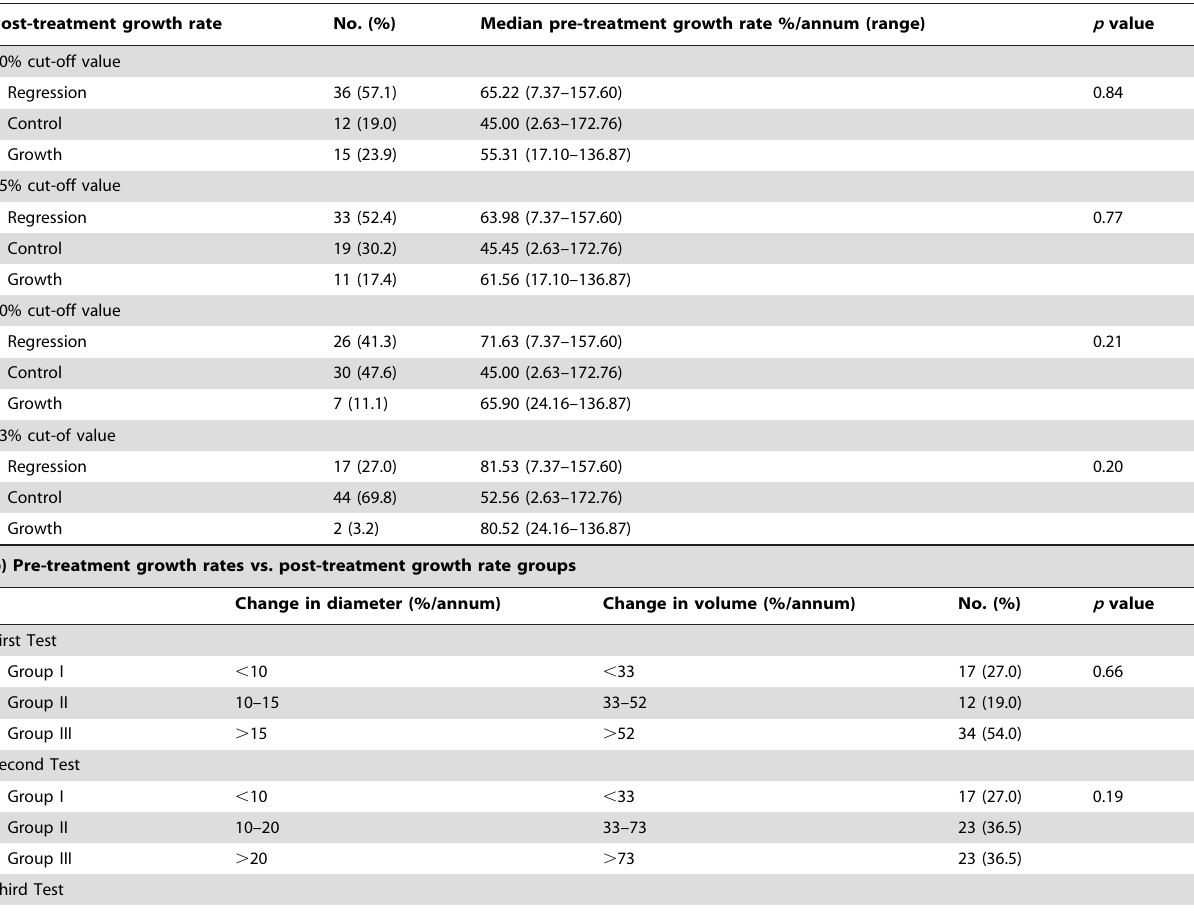
Table 4. a) Pre-treatment growth rates vs. post-treatment growth rate groups